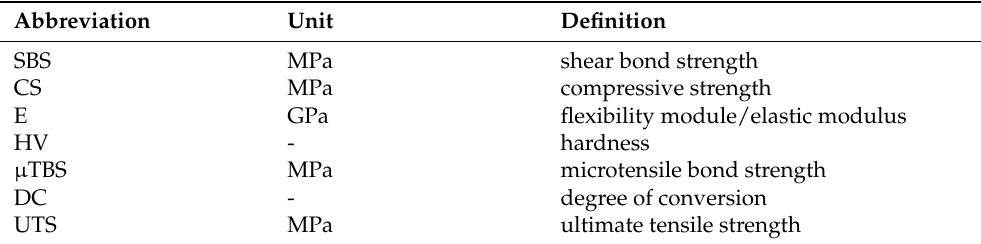
Table 1. The list of abbreviations used in this